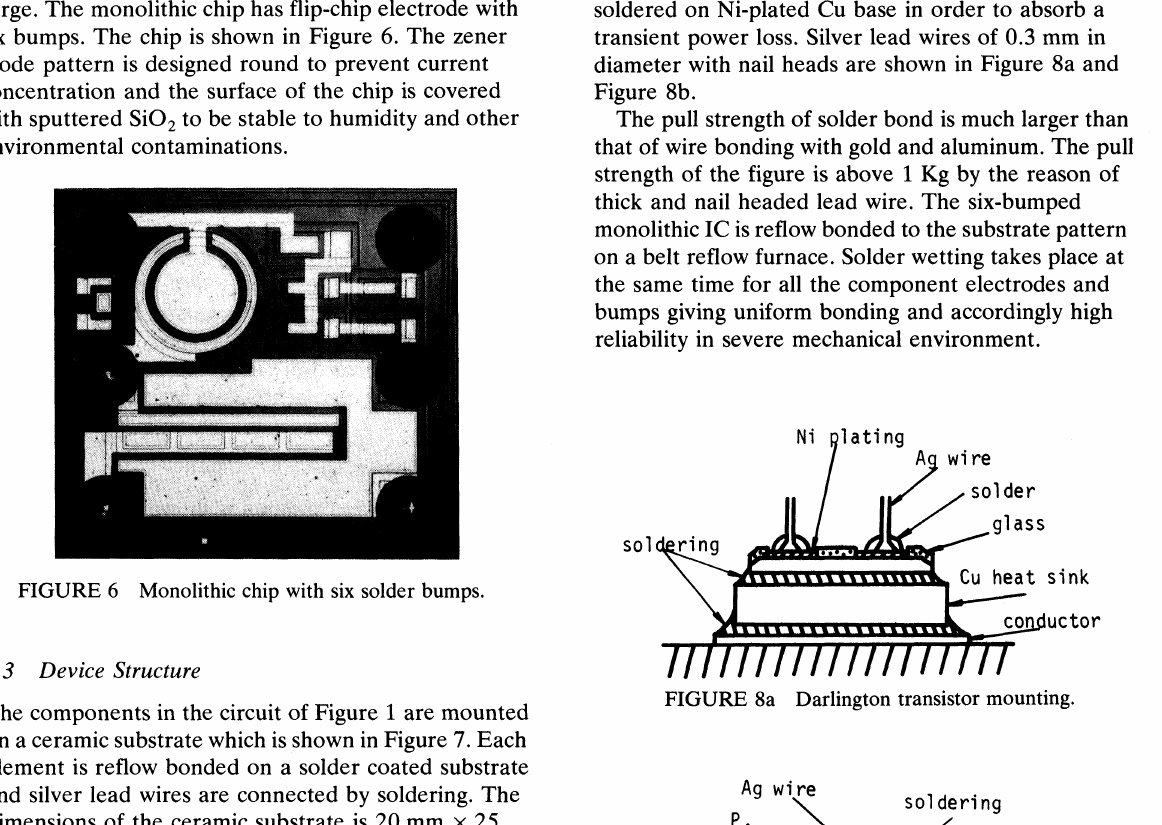
FIGURE 8a Darlington transistor mounting.